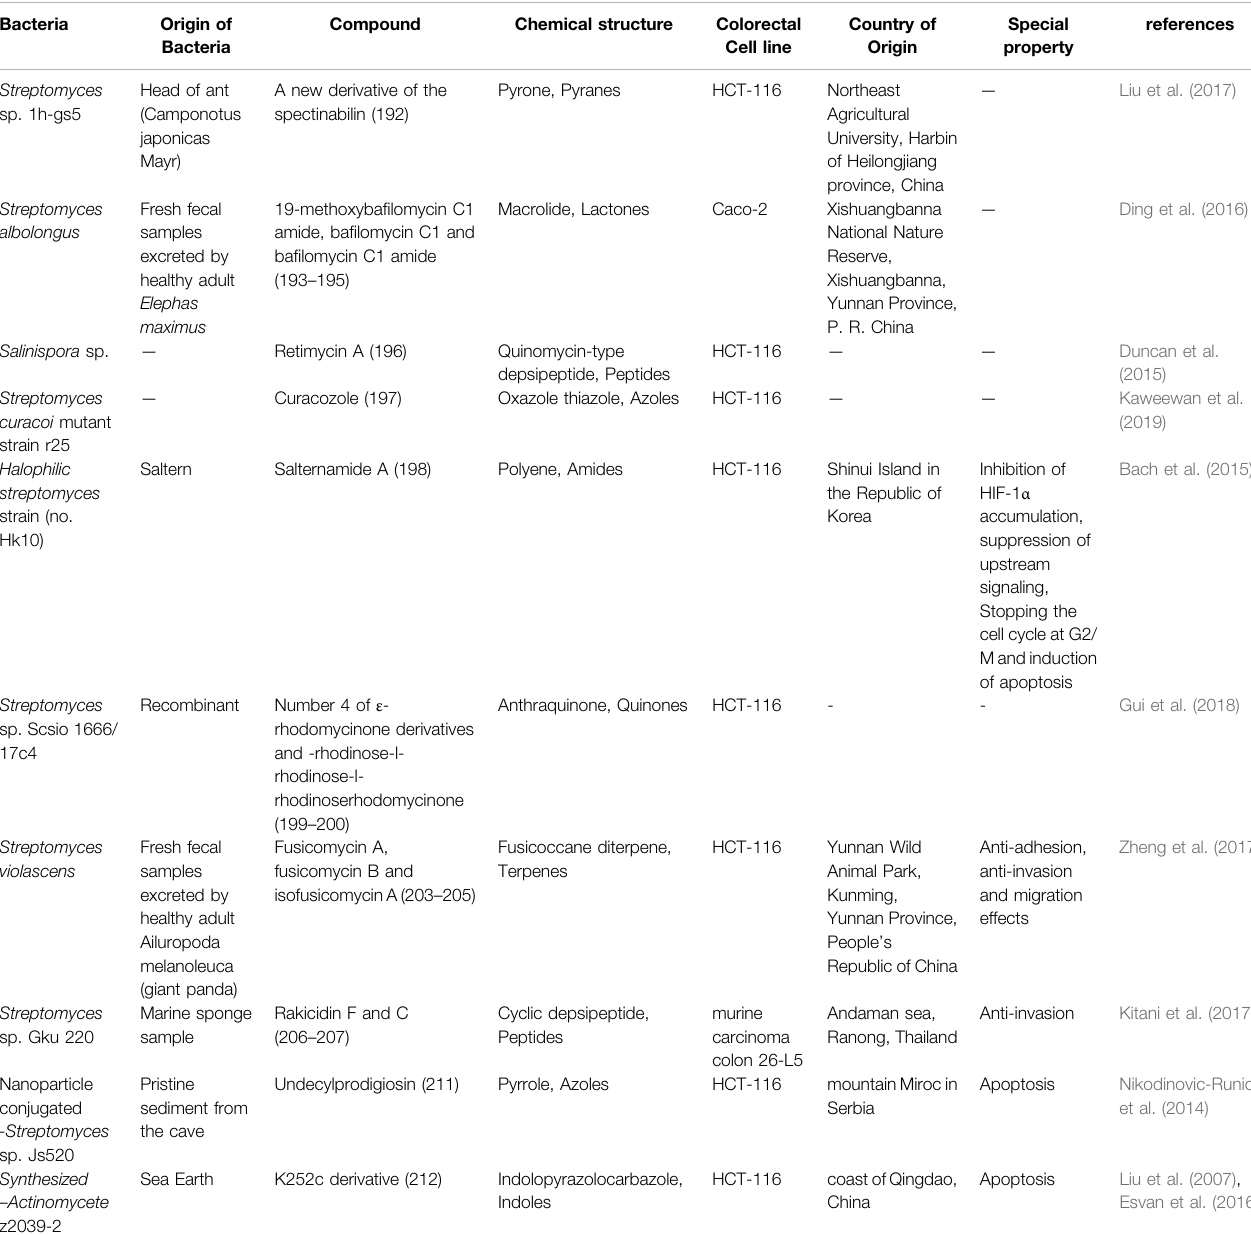
TABLE 3 | The structure of some NPs with anti-CRC properties from other actinobacteria and their mechanism of actions and origins.